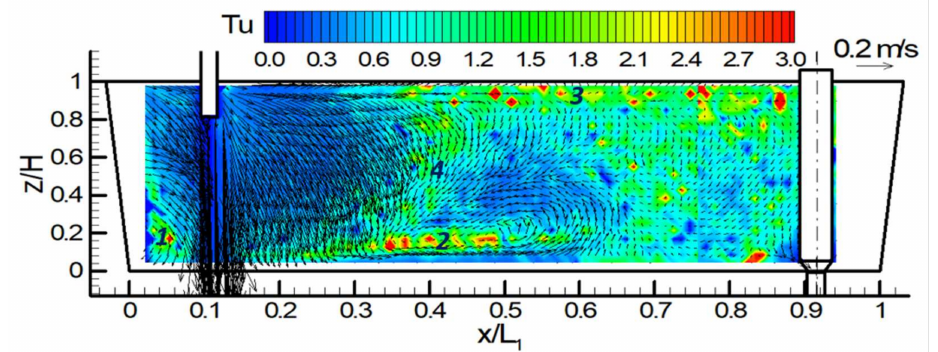
Figure 3. Measured velocity and turbulence intensity distribution at the central longitudinal plane in the water model of tundish (geometry scale 1:1.7) [28].